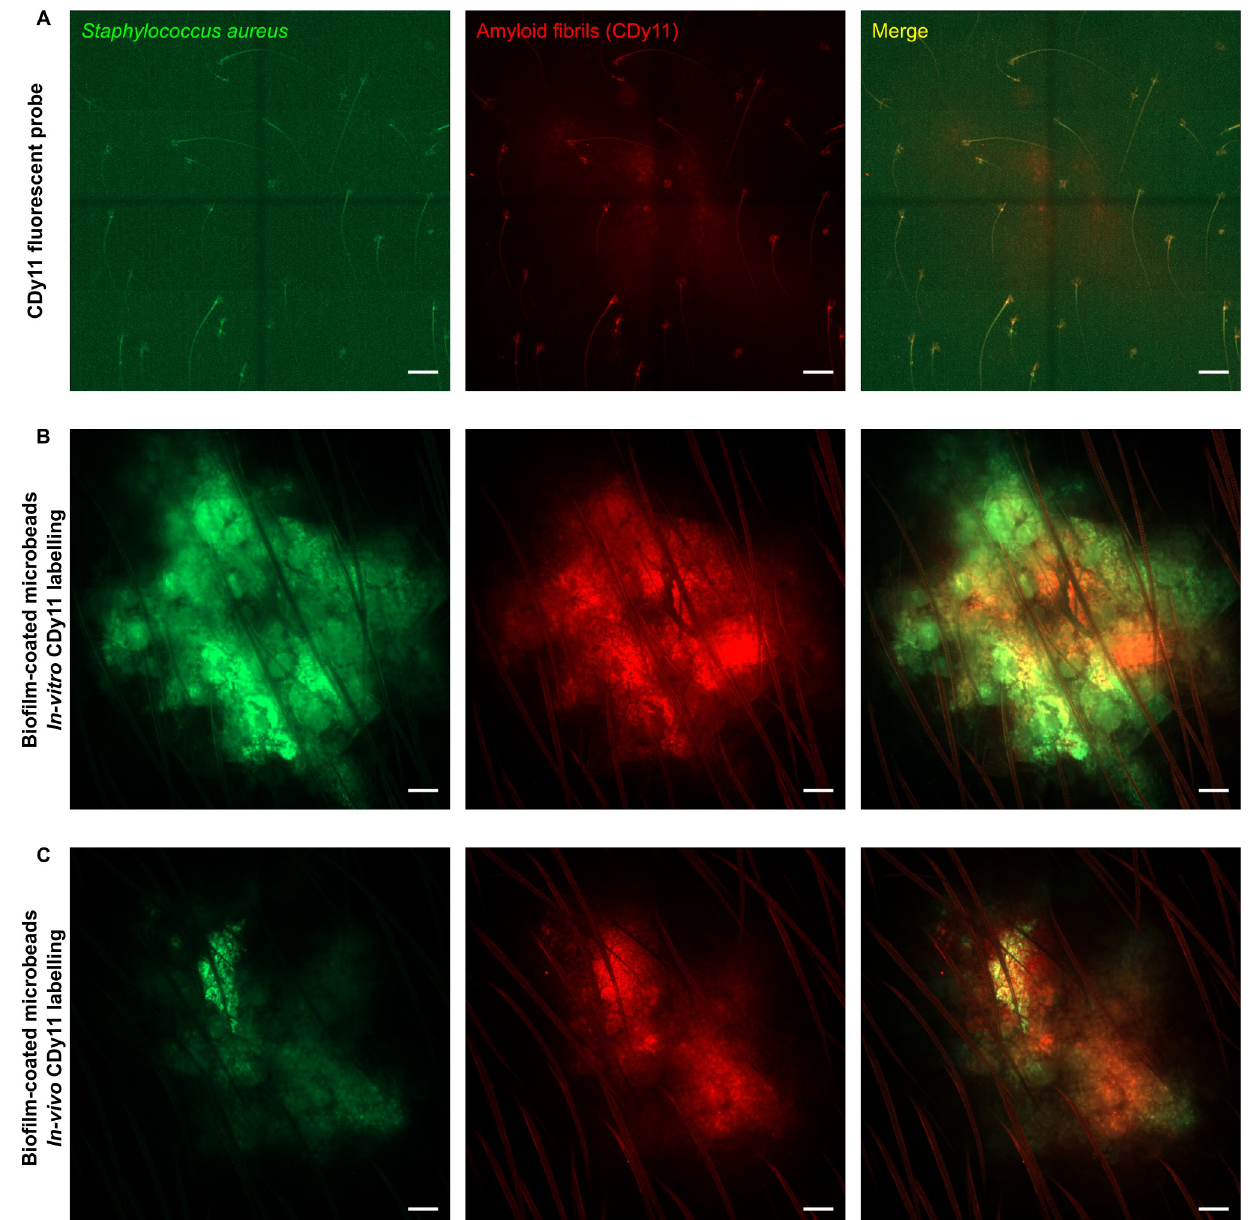
Fig 3. Intravital confocal imaging of CDy11 labelled biofilm-coated microbeads. Intravital confocal imaging after microinjection of only the CDy11 fluorescent probe (A) , of biofilm-coated microbeads after in vitro CDy11 labelling (B) or of biofilm-coated microbeads after in vivo CDy11 labelling (C) in the ear pinna of WT C57BL/6 mice. (A to C) Images show maximum intensity projections of GFP (green) and CDy11 (red) fluorescence. The merged image shows maximum intensity projections for both fluorescence channels. Scale bar: 100 μ m.